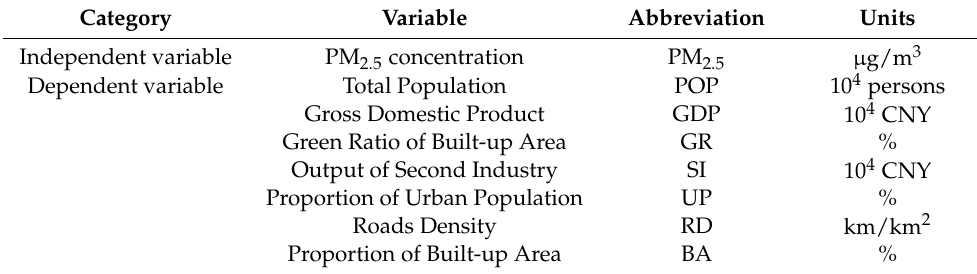
Table 1. Socioeconomic indicators and the abbreviations and